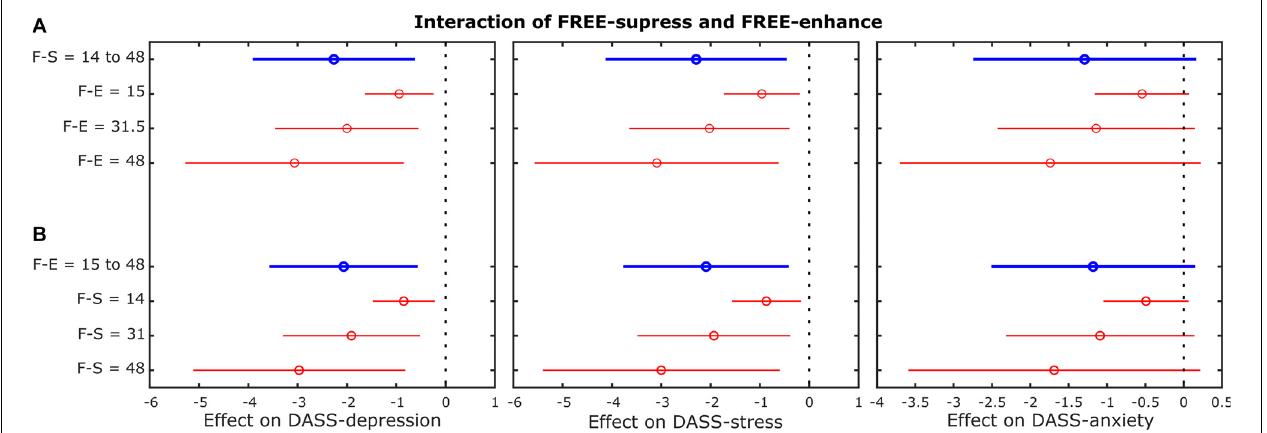
FIGURE 4 | Interaction effects of suppress and enhance abilities on psychopathological symptoms. Linear regression model depicting the impact of a change in enhance abilities given the suppress abilities (A) and a change in suppress abilities given the enhance abilities (B) to predict depression (left), stress (middle), and anxiety (right) symptoms. The blue circles depict the main effects (i.e., the magnitude of the effect) and the red circles depict conditional effects (e.g., the impact of a change in enhance abilities for fixed values of suppress abilities) at the minimum value of each response instrument (upper), the maximum value of each response instrument (lower), and the average value of the minimum and maximum (middle). Blue and red lines show the upper and lower limits for the main effect at 95% confidence bounds for the effect values. The vertical black dashed line indicates the limit between decrease (negative) and increase (positive) effects. F-S, FREE Suppression; F-E, FREE Enhancement; DASS, Depression, Anxiety, and Stress